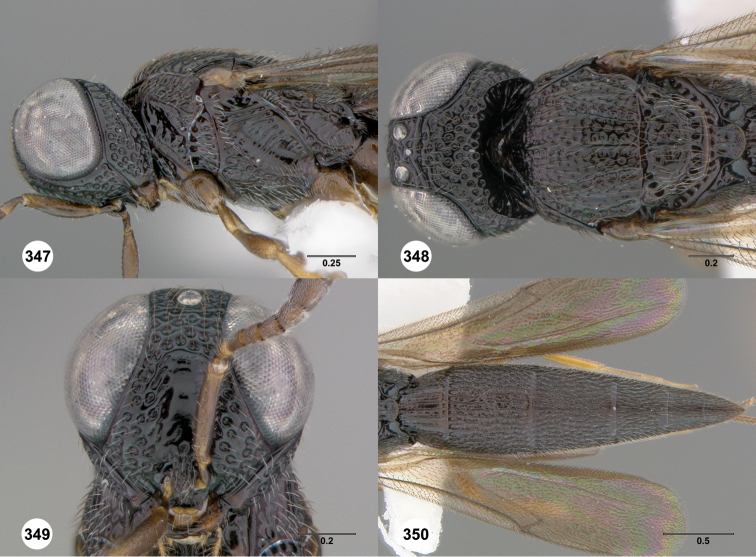
Oxyscelio spatulae sp. n., holotype female (OSUC 368914) 347 Head and mesosoma, lateral view 348 Head and mesosoma, dorsal view 349 Head, anterior view 350 Metasoma, dorsal view. Morphbank93